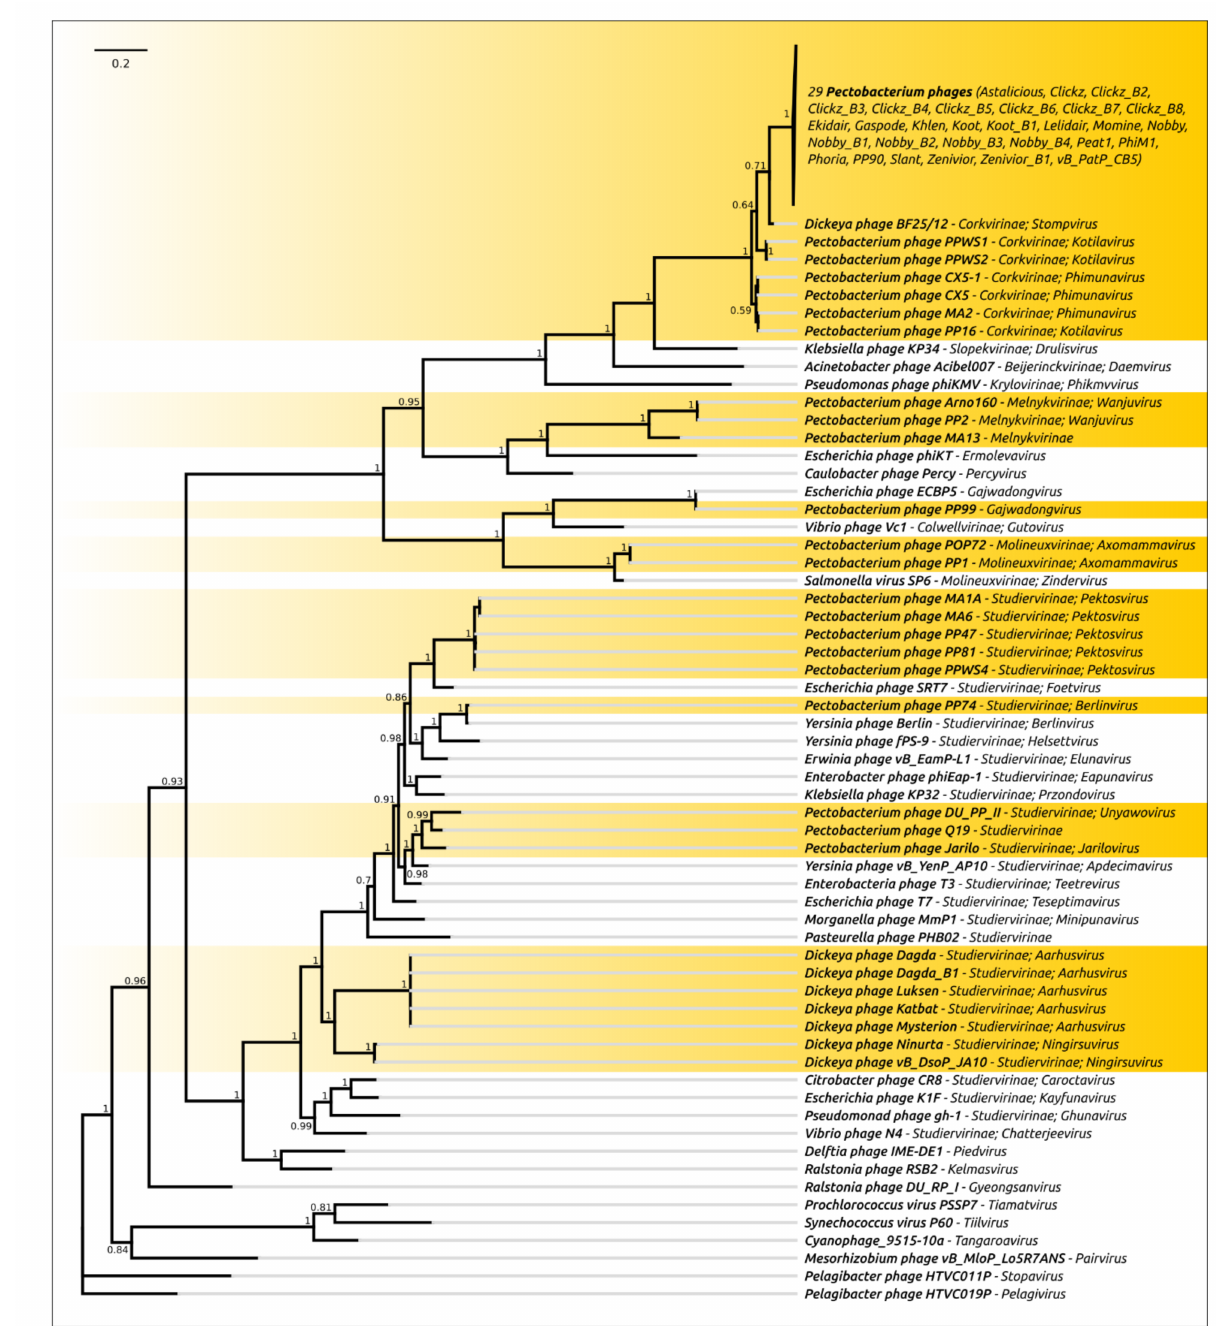
Figure 9. Phylogenetic tree obtained with MrBayes, based on the terminase large subunit amino acid sequences of Autographiviridae phages. Bayesian posterior probabilities are indicated near their branches. Taxonomic classification is shown to the right of the phage name. The scale bar shows 0.2 estimated substitutions per site and the tree was rooted to Pelagiabacter phage HTVC011P. The chain length was 3,300,000, the burn-in length was 300,000, the subsampling frequency was 200 and the average standard deviation of split frequencies was 0.0077. Eight monophyletic SRP branches are